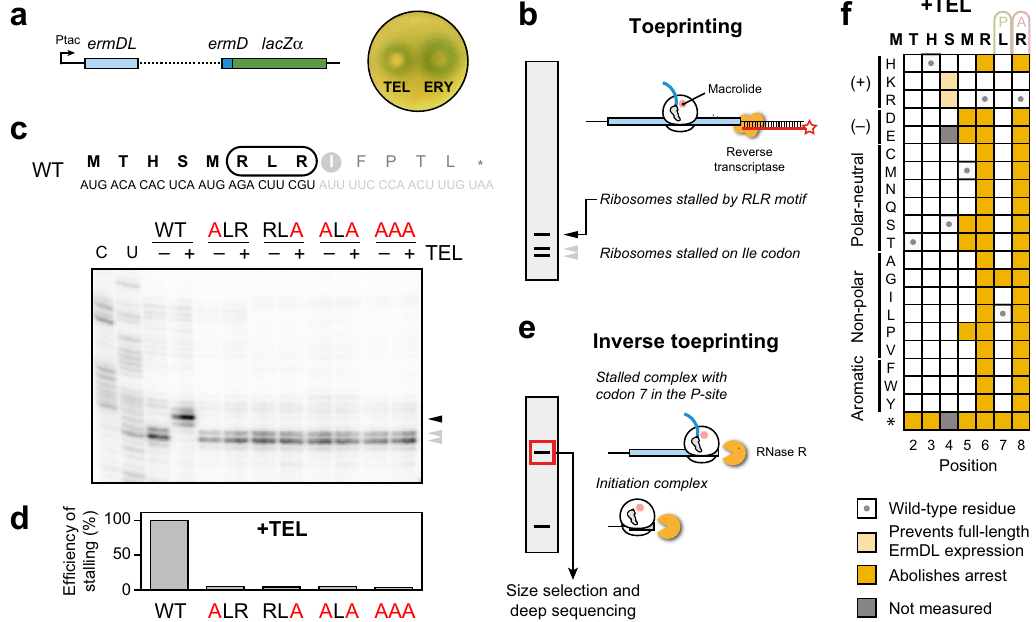
Fig. 2 Sequence dependence of translation arrest at ermDL in response to TEL. a Induction of expression of the ermD reporter by macrolides. Left: schematic of the ermDL-ermD 1-6 -lacZ α reporter construct. Right: Expression of the reporter, visualized as blue halos, is induced by diffusion of telithromycin (TEL) or erythromycin (ERY) on a lawn of Escherichia coli cells grown on LB agar reporter plates. b Overview of the toeprinting approach. Ribosomes that stall at a macrolide arrest motif (such as RLR) due to the presence of a macrolide antibiotic in a cell-free translation reaction produce a long cDNA band. Ribosomes that fail to stall at the arrest sequence are trapped at a downstream “ hungry ” codon (the trap codon) and produce a shorter cDNA band. c Top: The sequence of the ermDL ORF used for in vitro toeprinting assays. The RLR (Arg 6 -Leu 7 -Arg 8 ) motif encoded in the ORF is highlighted. The original ermDL ORF was modi fi ed to contain the trap codon Ile-AUU (circled in gray) at position 9. Bottom: Toeprinting assay testing TEL-induced translation arrest at ermDL sequences, where the RLR motif is intact (wt) or contains the indicated Ala mutations. The toeprint band produced by TEL stalled ribosomes with the Leu7 codon at the P site is indicated by a black arrow. The toeprint bands of ribosomes stalled at codon 8 due to the lack of Ile- tRNA (due to the presence of the Ile-tRNA synthetase inhibitor mupirocin in the reactions), are shown with gray arrows. C-speci fi c and U-speci fi c sequencing reactions are shown. d Ef fi ciency of TEL-mediated ribosome stalling estimated by quantifying the relative intensities of the toeprint bands of codons 7 and 8 in the mutant templates relative to those in the wt template. Stalling ef fi ciency at the wt template was set to 100%. Circles indicate the values of two independent experiments, whereas the bar represents the mean. e Overview of the inverse toeprinting methodology. f Sequence-function map for seven positions of the ErmDL peptide translated in the presence of TEL, where mutations that abolish arrest (score < − 1.5) are shown in yellow, as described in Supplementary Fig. 1. The ribosomal P (green) and A (pink) sites are indicated above the wild-type ErmDL sequence. Variants in gray were not measured and cells marked with a circle correspond to the wild-type amino acid. Mutations S4K and S4R lead to the appearance of a (K/R)MR arrest motif at position 4 that prevents the synthesis of the full peptide and leads to spuriously low scores for these two